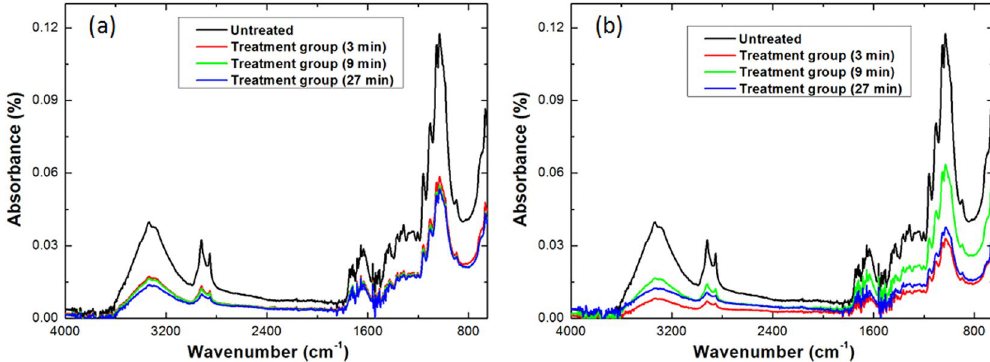
Figure 3. FTIR spectra of cotton seeds treated by ( a ) air and ( b ) N 2 flow discharges for different treatment times.